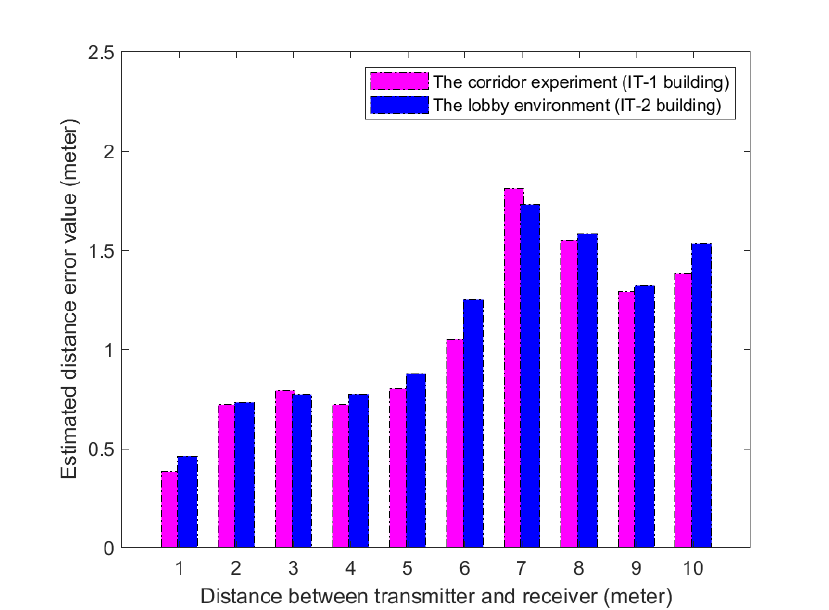
Figure 17. The comparison of the estimated distance error value between 1 m and 10 m.